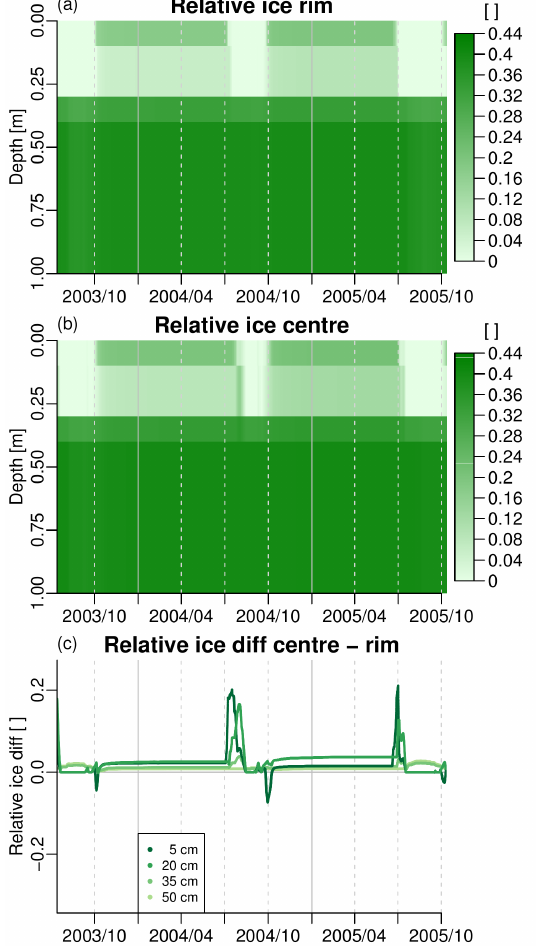
Figure B2. Modelled relative soil ice content of the uppermost me- tre at the (a) rim and (b) centre as well as (c) the difference centre minus rim at several depths. Solid lines indicate 1 January; dashed lines indicate 1 April, 1 July and 1 October of the respective year. The scale maximum for (a) and (b) is the field capacity, ceiled to two digits. The scale for (c) is the same as for the difference of the modelled relative soil moisture